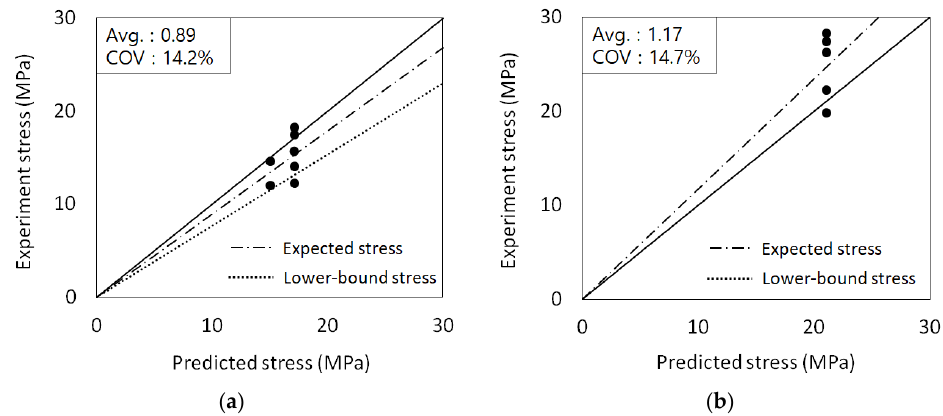
Figure 15. Predicted and test compressive strengths for prisms strengthened on one side: ( a ) Red clay brick masonry; ( b ) concrete brick masonry. Table 8. Nominal strength and modification factors for red clay brick masonry.